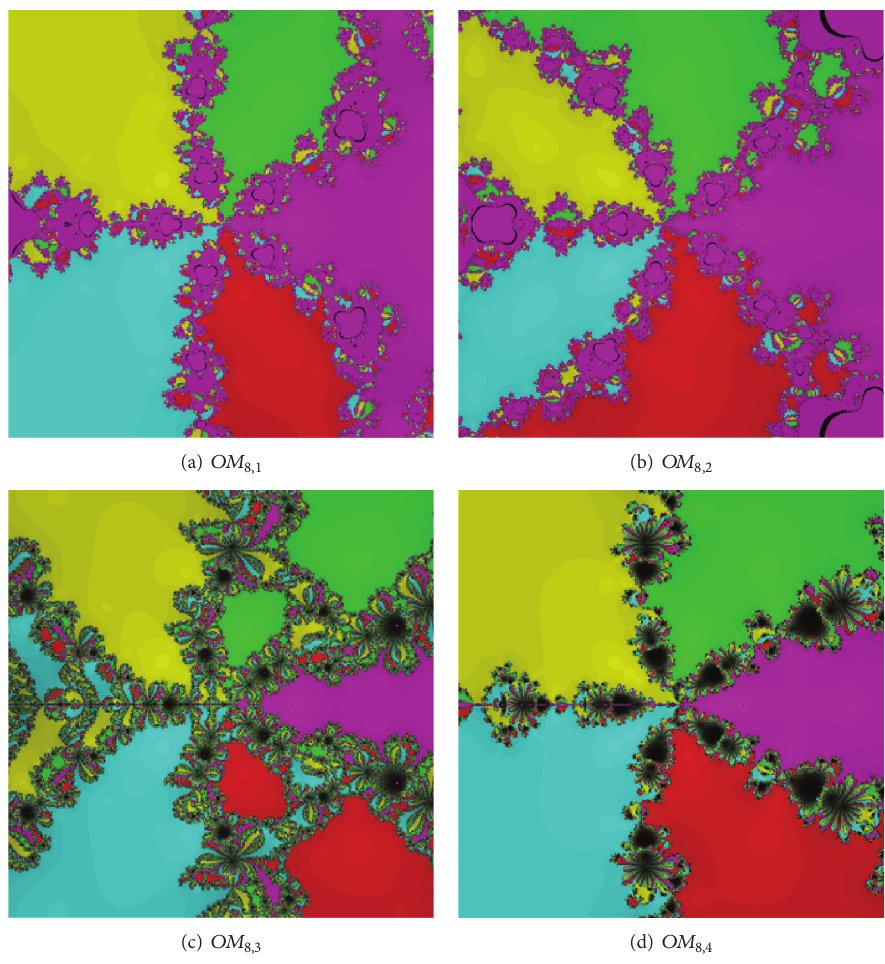
Figure 4: Basins of attraction for nonpolynomial 𝑃 4 (𝑧) = (𝑧 4 − 1/𝑧)